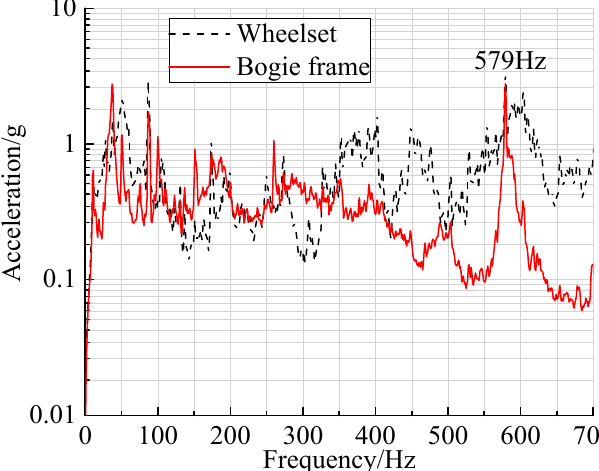
Figure 15. Lateral vibration acceleration spectra of the wheelset and bogie frame.